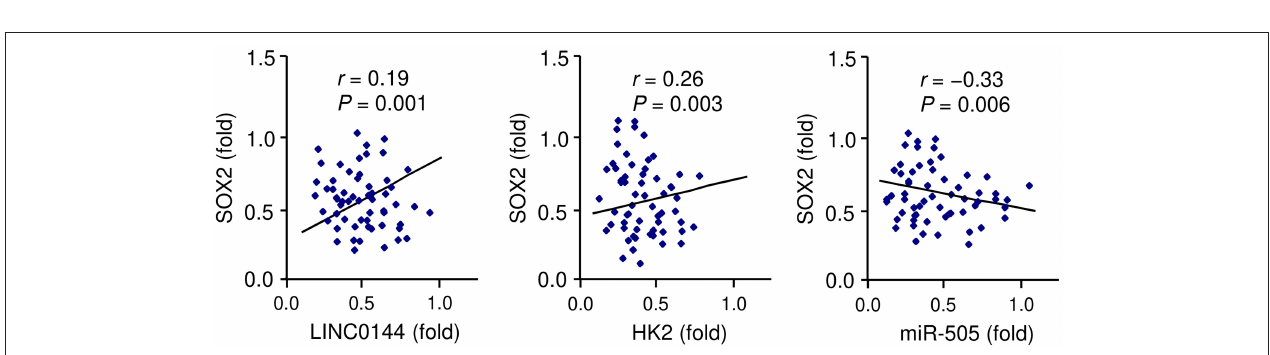
FIGURE 7 | LINC01448 promotes cell proliferation, invasion, sphere formation, and glycolysis by repressing miR-505 expression. (A) Cell functional assays were evaluated in AsPC-1 cells transfected with (or without) the LINC01448 expression vector, along with (or without) miR-505 mimic. (B) Cell functional assays in PaCa-2 cells transfected with (or without) LINC01448 siRNA-1, along with (or without) miR-505 inhibitor. (C) Western blotting analysis of HK2 expression in PaCa-2 cells transfected with (or without) LINC01448 siRNA-1, and in AsPC-1 cells transfected with (or without) LINC01448 expression vector. * P < 0.05.